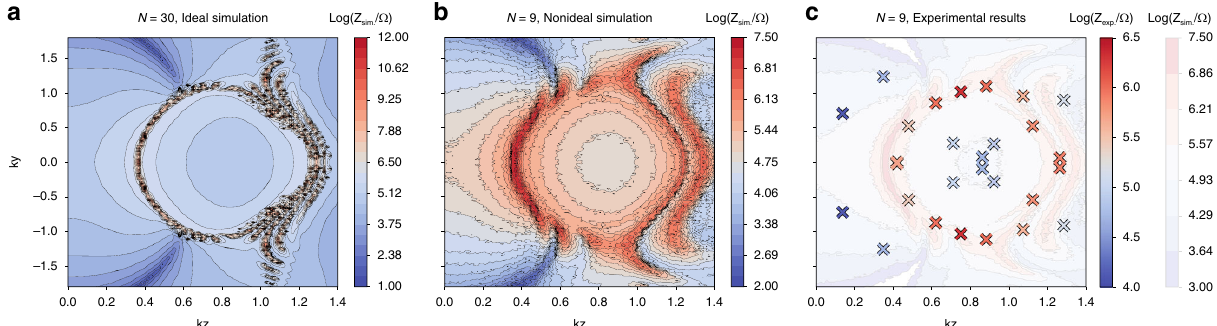
Fig. 5 Simulated impedances vs. experimental measurements. a Hopf-link (dark cyan) and the drumhead region (orange) of elevated impedance it encloses, computed in the “ clean ” limit absent of parasitic resistances and component uncertainty. Simulation was performed with N = 30 unit cells at resonant frequency 795.7 kHz for the circuit Laplacian in Eqs. (15) to (18) (in “ Methods ” ), truncated from that of Fig. 4a to facilitate experimental construction. b Impedance map of the same circuit, but simulated for our N = 9 experimental setup with empirically determined parasitic inductor and capacitor resistances R p L = 0.11 Ω and R p C = 0.03 Ω , and capacitor/inductor tolerances of 1%. c Corresponding experimentally measured impedance (crosses) with distinct elevated region, which agree well with simulation (lighter background contours from ( b )). Frequency used is 740 kHz, offset from the predicted 795.7kHz to account for uncertainties in the tuning circuitry (see “ Methods ” and Supplementary Table 3).